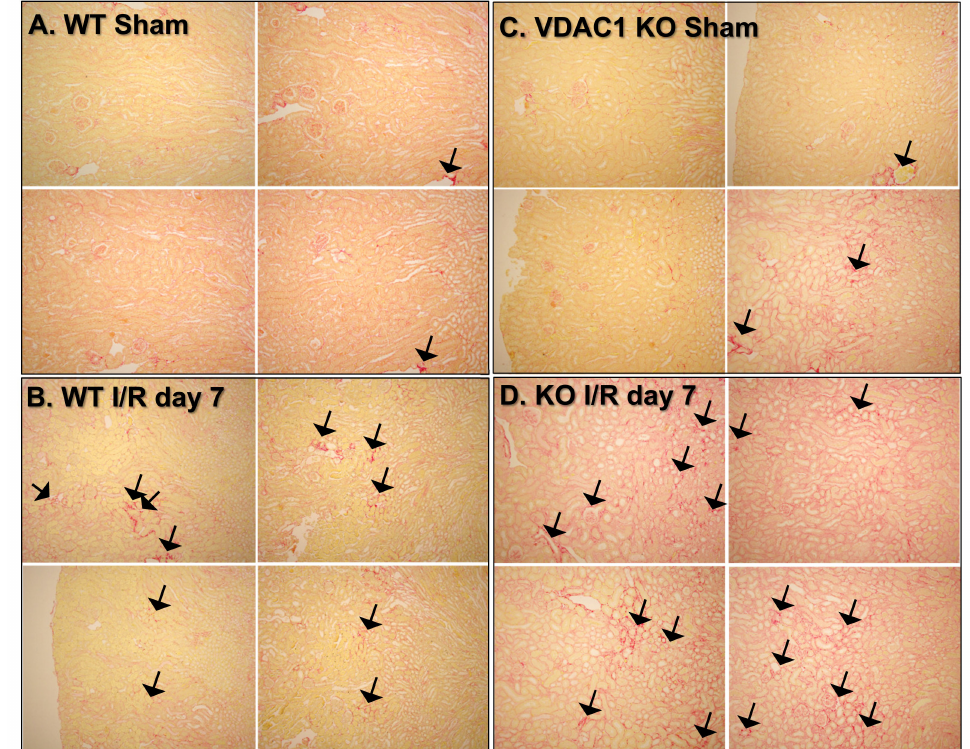
Figure 4. Deletion of VDAC1 exacerbates ischemia-induced interstitial collagen accumulation after acute injury. Kidneys were harvested before (sham) and on day 7 after ischemia (I / R) to assess collagen accumulation in the tissue. Formalin-fixed and para ffi n-embedded 4–8- µ m tissue sections were stained with picro-sirius red. Collagen staining in the renal interstitium was assessed by light microscopy using circularly polarized light. The images were captured using Nikon Eclipse E800 microscope using Nikon 10 × Plan Apo objective. Magnification: 122 × . ( A ) Representative kidney sections from three wild-type (WT) sham mice. ( B ) Representative kidney sections from four wild-type (WT) mice on day 7 after ischemia. ( C ) Representative kidney sections from three sham VDAC1-deficient (KO) mice. ( D ) Representative kidney sections from four VDAC1-deficient (KO) mice on day 7 after ischemia. The arrows mark sites with increased collagen